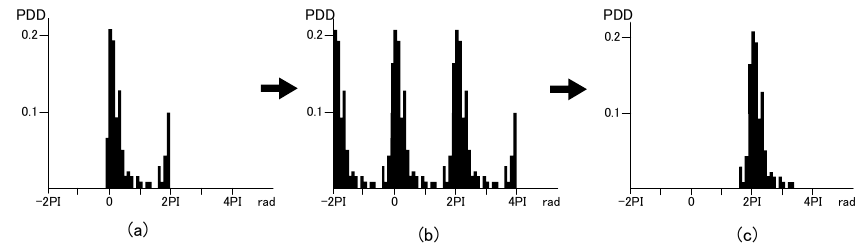
Fig.2 Processing of probability density distributions of phase lag between